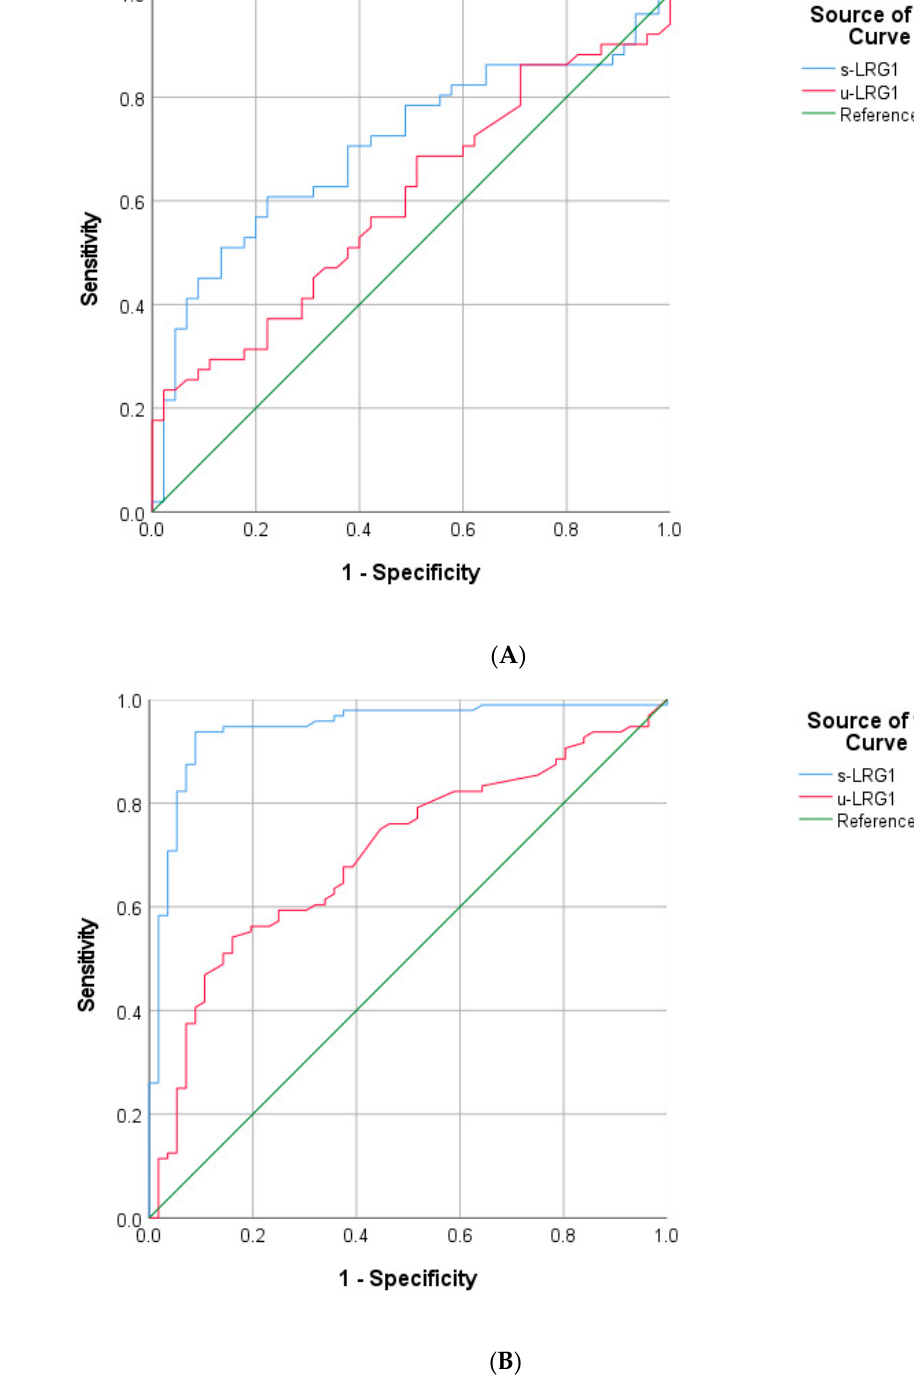
Figure 3. Analysis of s-LRG1 and u-LRG1 for sensitivity and specificity. The ROC curve for s-LRG1 analysis AcA vs. AuA children demonstrated AUC of 0.69 (95% CI 0.59–0.80) at cut-off value of 84.05 μ g/mL and for u-LRG1 AUC of 0.60 (95% CI 0.49–0.71): ( A ) The ROC curve for s-LRG1 analysis AA vs. Ctr demonstrates AUC of 0.95 (95% CI 0.91–0.99) at cut-off value of 51.69 μ g/mL and for u-LRG1 AUC of 0.70 (95% CI 0.62–0.79) at cut-off value of 0.175 μ g/mL ( B ). The u-LRG1 cut-off value for AA patients was 0.175 μ g/mL, and for AcA was not significant. The ROC curves demonstrate an AUC of 0.70 (95% CI 0.62–0.79) and 0.60 (95% CI 0.49–0.71) respectively (Figure 3A,B). u-LRG1 for appendicitis had a sensitivity of 54.2% and specificity of 83.9%. The efficiency of u-LRG1 as a predictive marker of AcA versus AuA was found to be insignificant ( p = 0.089) (Figure 3A). Contrarily, u-LRG1 proves to be an adequate predictive marker of AA ( p < 0.001) (Figure 3B). 4. Discussion Accurate, early diagnosis of acute appendicitis continues to be a major diagnostic challenge, and biomarkers potentially can confirm appendicitis and determine the severity. Current inflammatory markers of leukocytosis and CRP are too vague to accurately determine appendicitis with high specificity or sensitivity [5]. The authors of this study assessed LRG1 as a potential diagnostic tool because its marked expression is believed to represent an increased inflammatory process in patients with appendicitis. The primary objective was to evaluate the significant potential of LRG1 in distinguishing AcA from AuA as to commence adequate therapy. This study demonstrated that patients with appendicitis had significantly elevated s-LRG1 and u-LRG1 concentrations compared to the control group and had a significant difference of s-LRG1 concentrations in AcA and AuA, indicating that s-LRG1 correlates with the severity of appendicitis. This study met many limitations as testing was performed at a single-center with a finite range of resources during inconsistent hours which limited patient participation. Most patients received either antibiotic and/or intravenous fluid therapy prior to surgery and sample collection, which may have affected biomarker concentrations. The usage of different Human Leucine-rich alpha-2-Glycoprotein 1 ELISA kits by other publications make the comparison with the results of this study arduous. The analysis of LRG1 samples was performed at a clinical research laboratory, not at the hospital’s laboratory, and